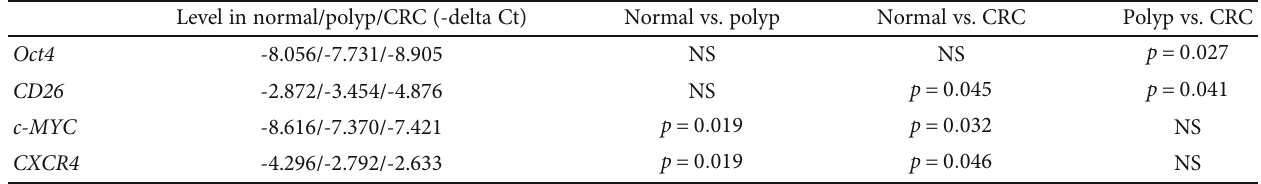
Normal Figure 1: Four pluripotency-associated genes showing signi fi cant di ff erential expression pattern among normal, polyp, and CRC patients. Table 2: Detailed comparison of Oct4 , CD26 , c-MYC , and CXCR4 levels in normal, polyp, and CRC patients. Level in normal/polyp/CRC (-delta Ct) Normal vs. polyp Normal vs. CRC Polyp vs.